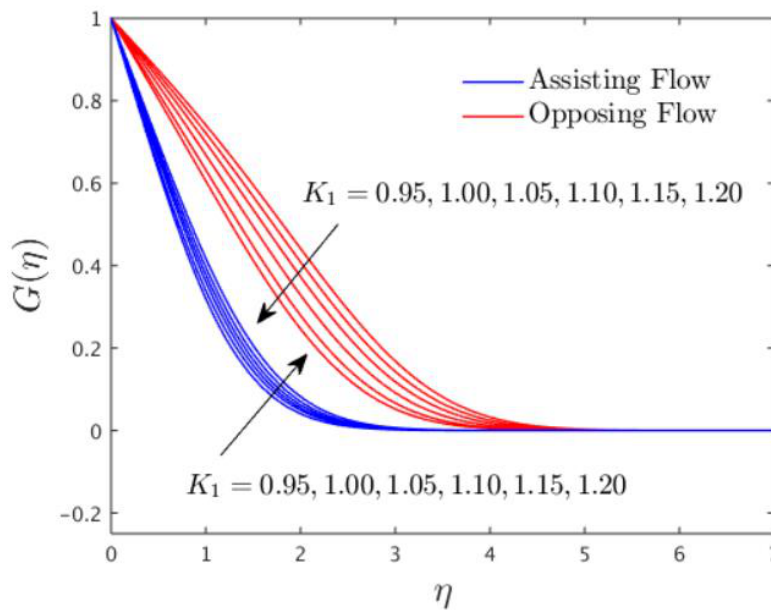
K . Figure 6. G ( η ) against K K . 1 1 1